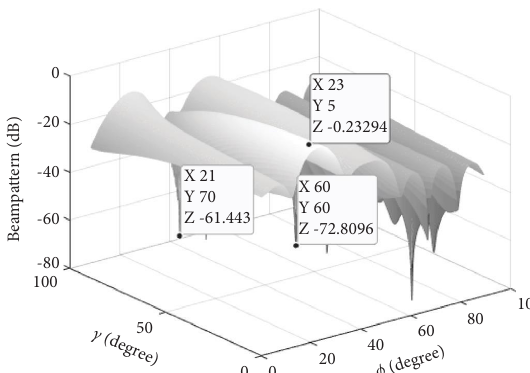
Figure 3: Te polarization-space beampattern of the proposed method with a parameter error of the desired signal.